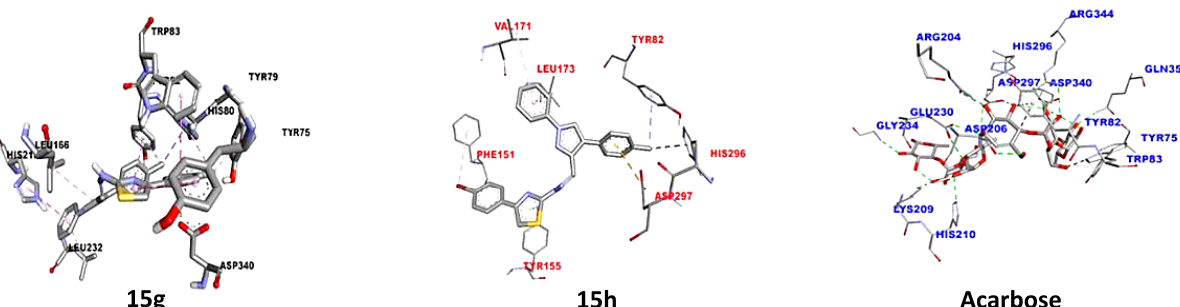
Figure 12. 3D Interactions of compounds 151g , 151h , and acarbose with binding sites of Aspergillus oryzae α -amylase (PDB ID: 7TAA). Image adapted from Duhan et al. [140].